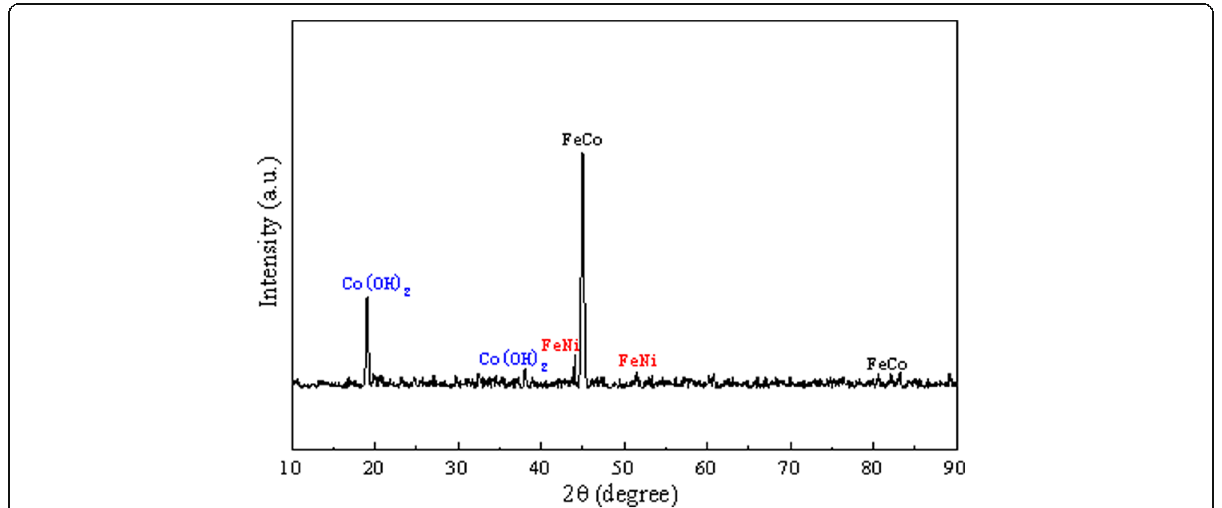
Fig. 2 The XRD spectrum of MNs